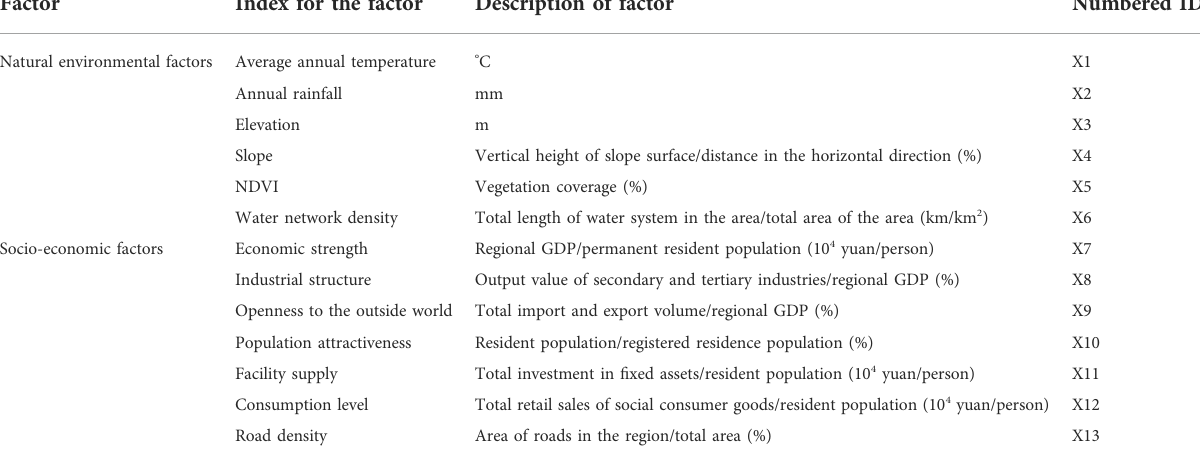
TABLE 4 Evaluation index of in fl uencing factors and their de fi nitions.